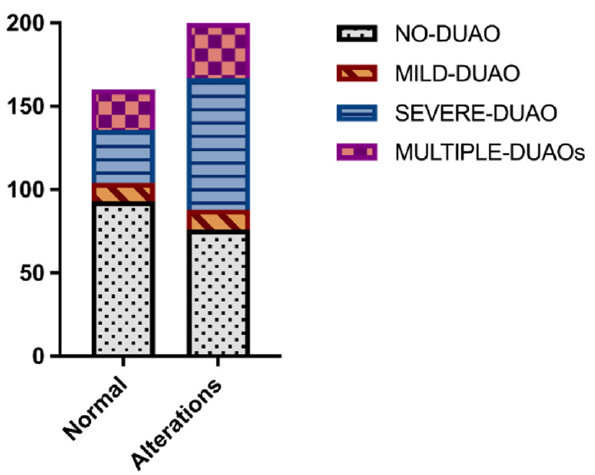
9 of 15 groups ( p = 0.0534). In particular, a flaccid appearance of epiglottis was more frequently observed in the horses with DDSP diagnosed at HSTE (60.78%) compared to the horses without DDSP (39.22%) ( p = 0.0007) (Figure 3). No differences were observed in the fre- quency of DDSP at rest between the horses with and without DDSP during HSTE, nor in the frequency of resting DDSP and epiglottis flaccidity between the horses with and with- out NPC and MDAF. The horses showing DDSP episodes at rest had a higher PLH grade (median 2, IQR 1–3) compared to the horses without resting DDSP (median 2, IQR 1–2) ( p = 0.0052) and more frequently showed a flaccid appearance of the epiglottis (resting DDSP 31.63%, no resting DDSP 12.21%, p < 0.0001). Among the seven horses showing EE during exercise, three also presented persistent EE visible at resting endoscopy, two had a normal